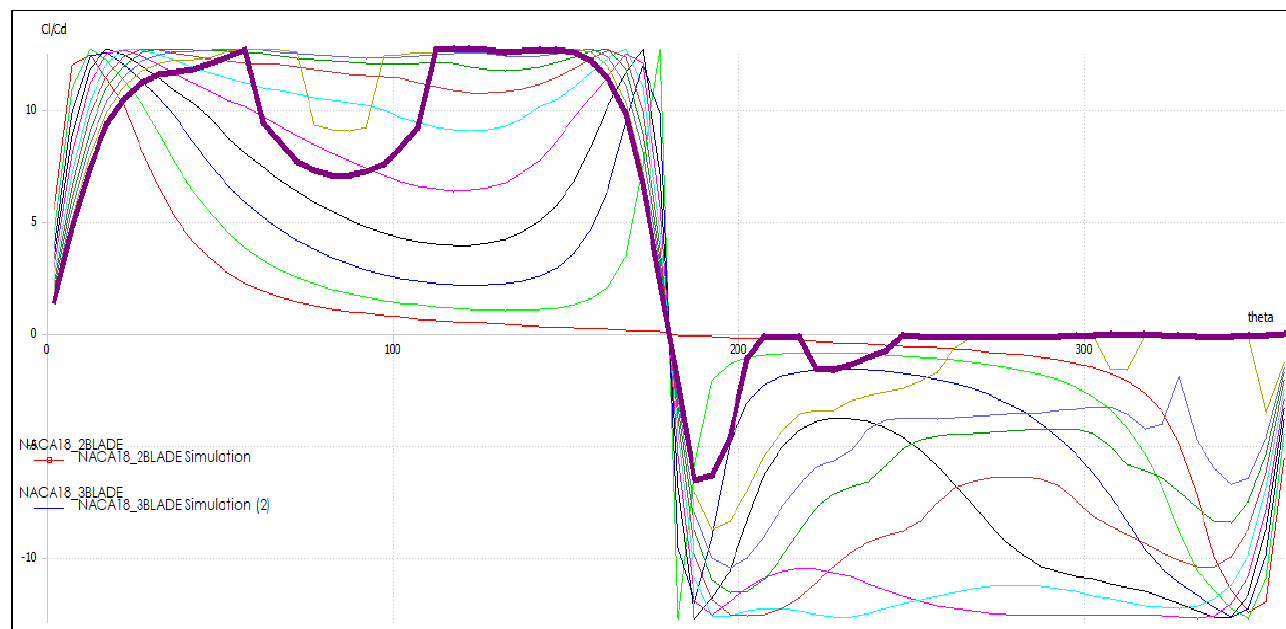
Figure 39. Cl/Cd vs theta plot of mid-section for TSR 6